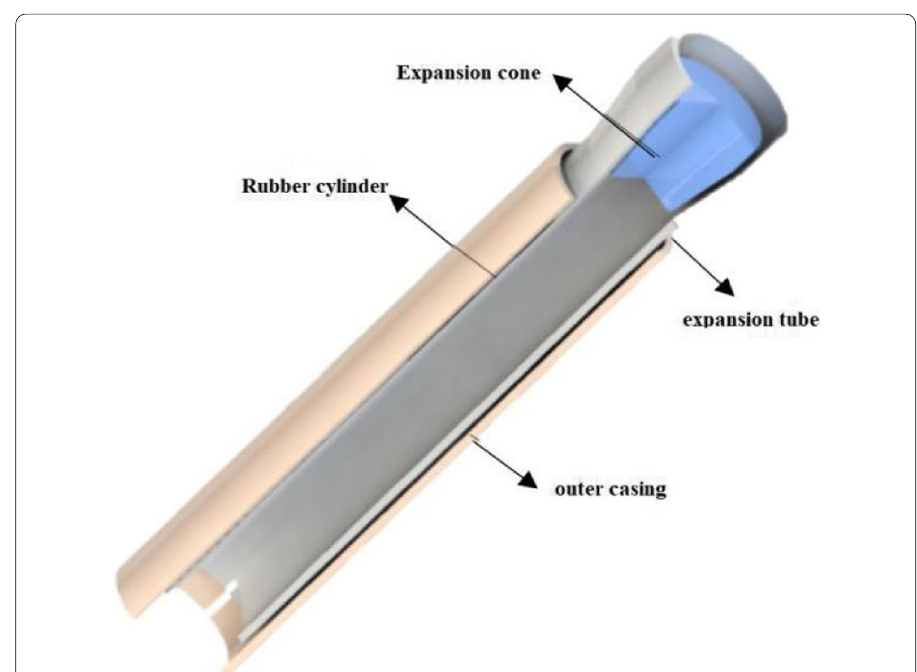
Fig. 2 Model of expansion liner hanger with rubber cylinder